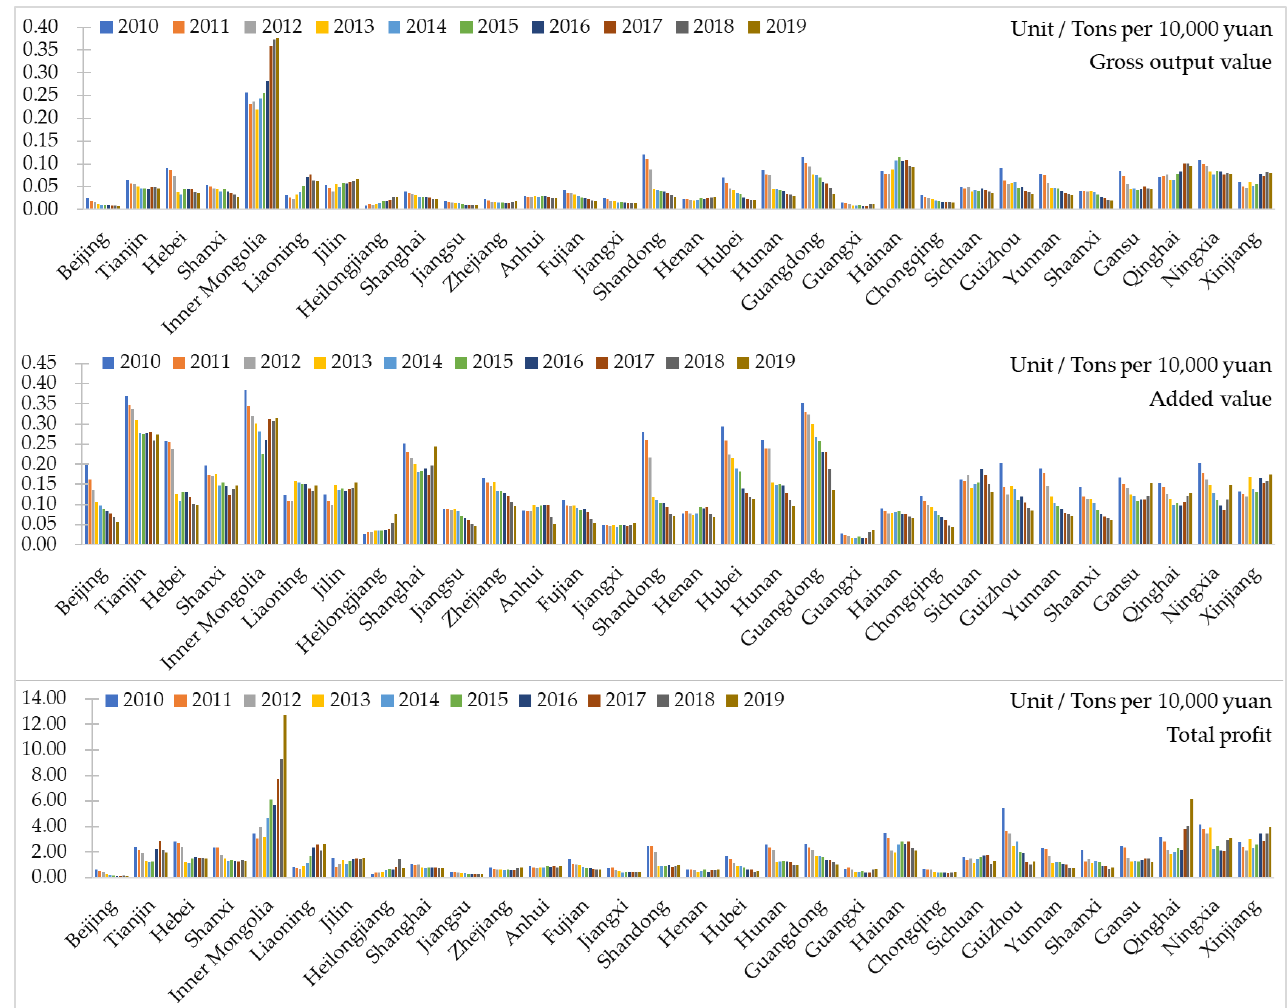
Figure 6. Temporal change characteristic of ECI on construction industry from 2010 to 2019.